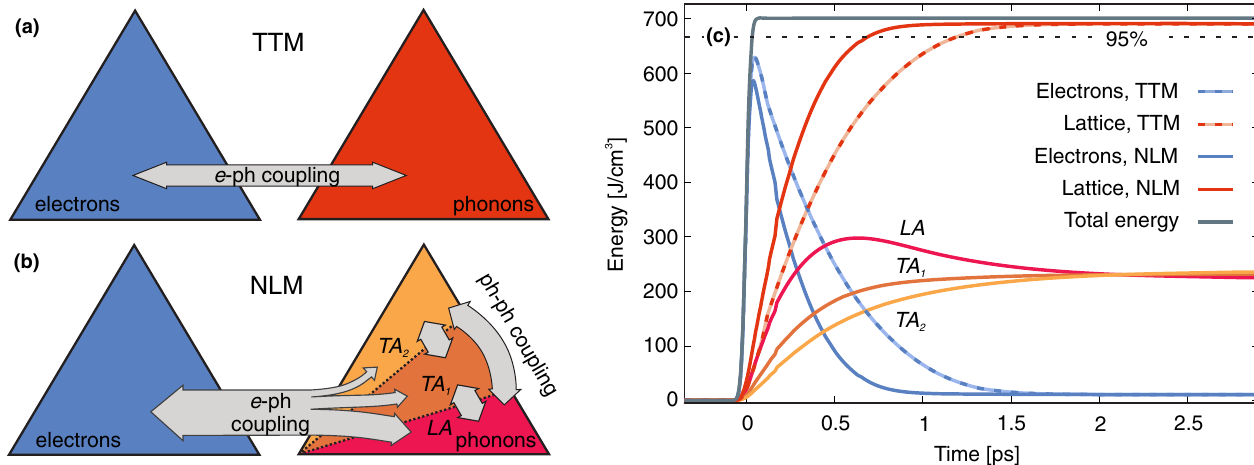
FIG. 6. (a),(b) Schematic representation of the TTM and the NLM. In the latter, the phononic system is subdivided into its branches and the couplings are considered separately. The widths of the arrows are proportional to the coupling strengths retrieved from theory and experiment. (c) Temporal evolution of the energy content in the electronic (dash-dotted lines) and lattice (solid lines) subsystems for an excitation density of 680 J = cm 3 according to the NLM and the TTM. The energy content of the individual phonon branches is shown as dotted lines. The black dashed line indicates 95% of the energy which is eventually transferred from electrons to the